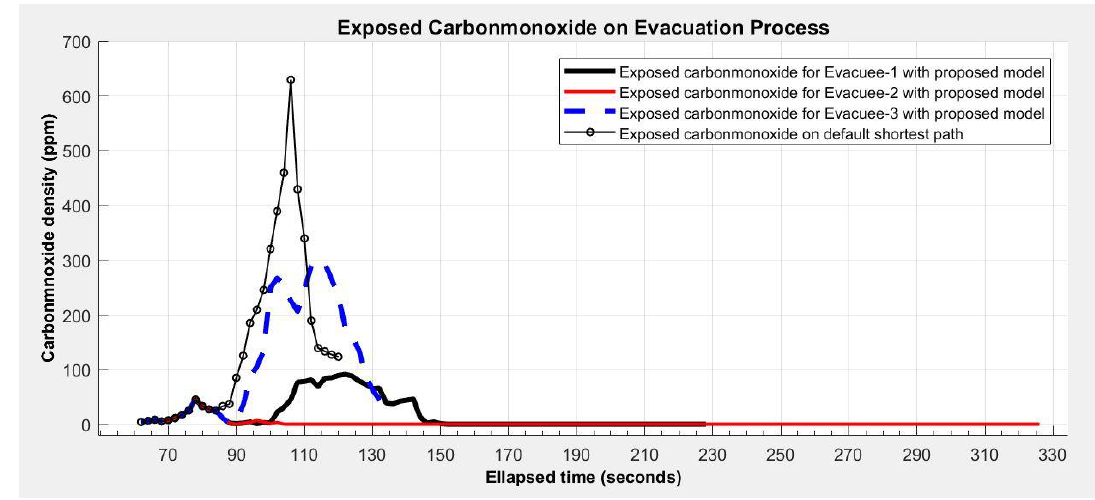
Figure 11. Carbon monoxide density–time chart.